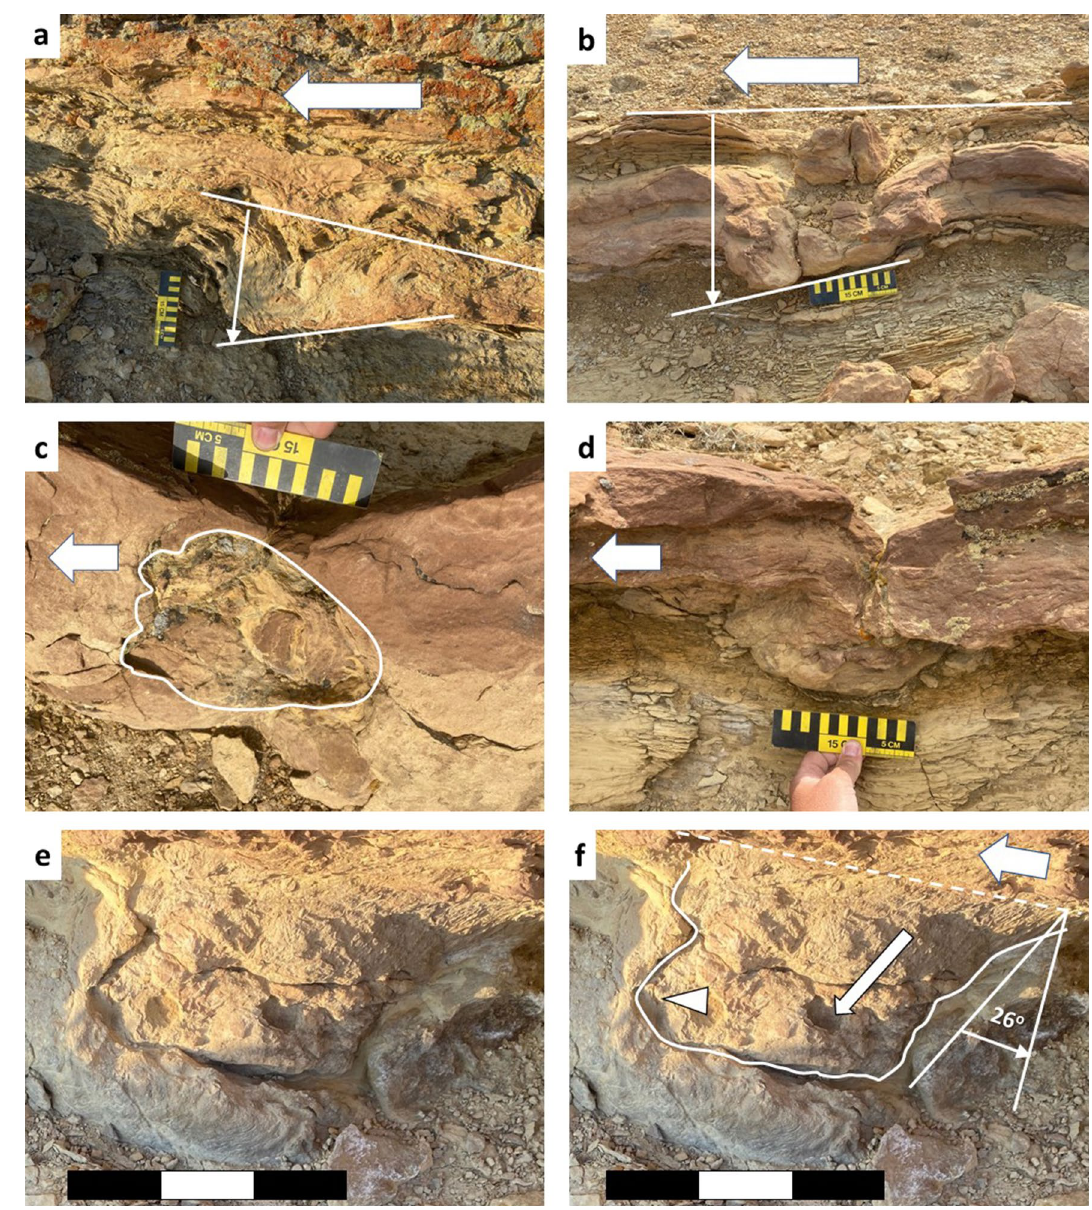
Figure 4. Photographic evidence of dynamic locomotion in tracks. a , b , d – f are in cross-section. c is surface view. Scale bars are 15 cm. Large arrows indicate direction of travel (southeast). ( a ) Downward rotation of anterior part of the pes and digits; ( b ) Downward rotation with disruption of underlying, heterolithic bedding; ( c ) Pes with narrow heel and poorly preserved digit impressions; ( d ) Cross sectional view of c showing clear deformation of underlying sediment and penetration into underlying, heterolithic bedding; ( e ) Example of deep pes track with natural cast exposed in cross-sectional view; ( f ) Interpretive outline of e . Small arrow indicates angle of impact during step-in (26° from vertical).Triangle indicates expansion of digits into substrate with moderate downward rotation. Drawings made by A F-J W in Adobe Illustrator 2021 (version 25.2.1, https:// www. adobe. com/ produ cts/ illus trator. html). Photographs by A F-J W and compiled in Microsoft PowerPoint (version 16.0.13801.20266, https:// www. micro soft. com/ en- us/ micro soft- 365/ power